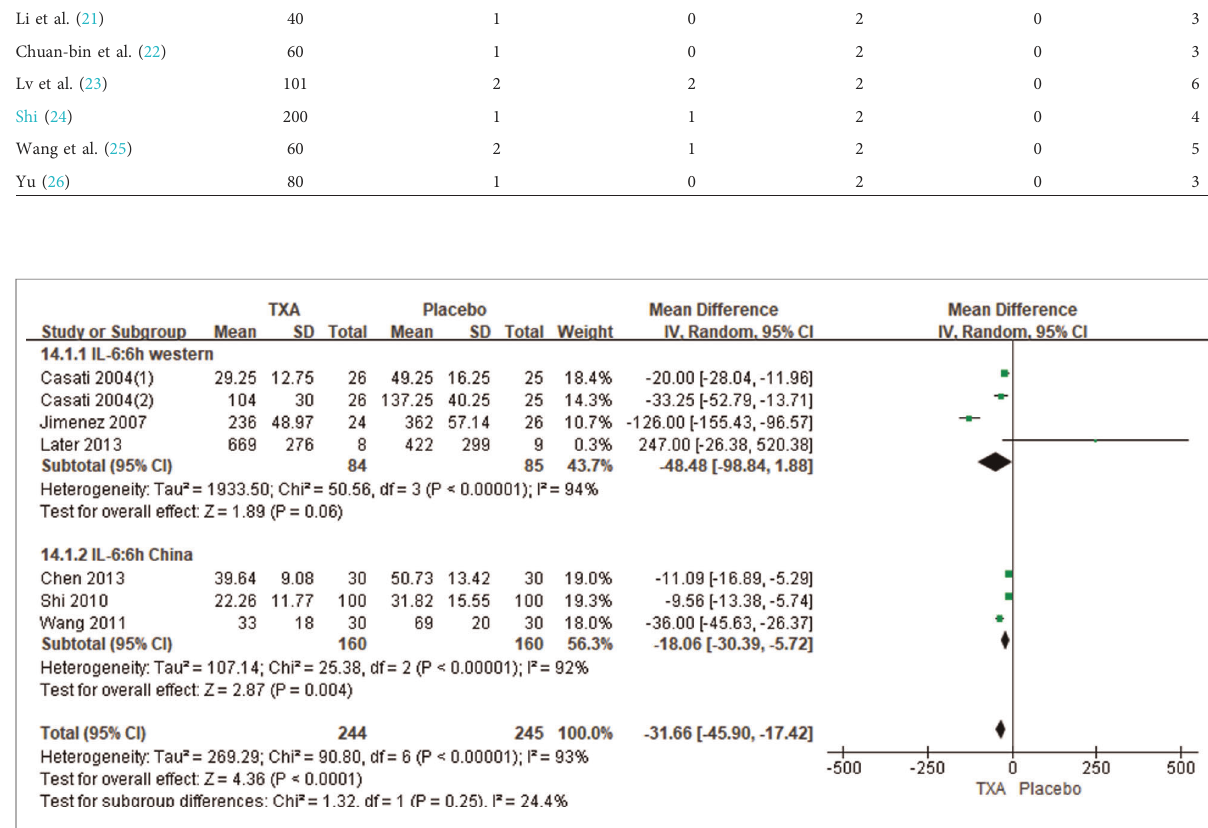
FIGURE 4 Forest plot comparing TXA and placebo for the postaperative 6 h IL-6